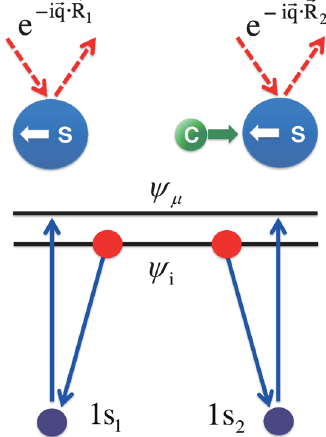
FIG. 3. Schematic showing an analogy between the RIXS process in CS 2 and the Young double-slit diffraction experiment, where the role of the slits is played by the sulfur atoms serving as the scattering centers. Dynamic symmetry breaking due to asymmetric stretching vibrations in the CS 2 molecule plays only a minor role in our case and does not affect the RIXS